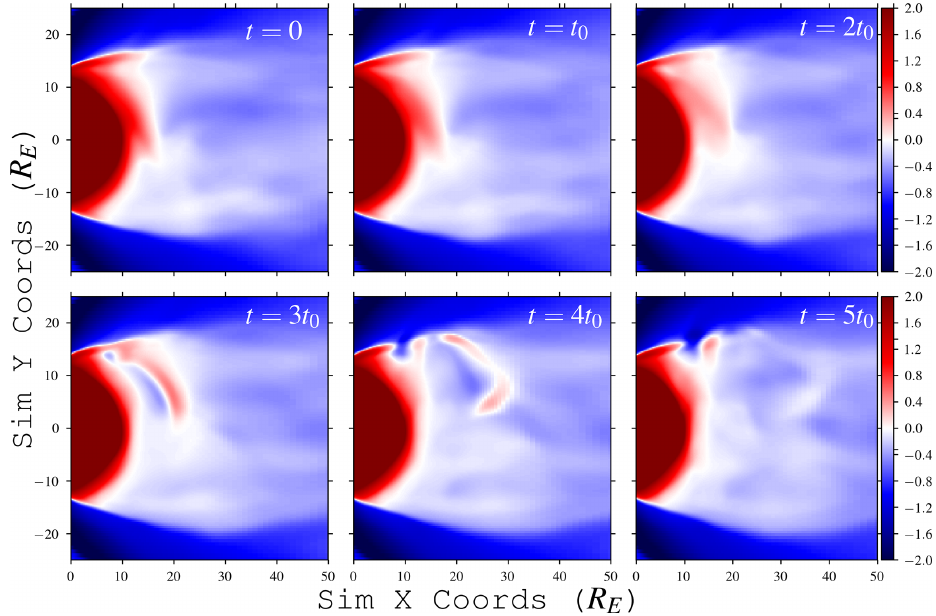
Figure 5. Formation and evolution of a global dipolarization over 5 t 0 ≈ 5 . 4min, as seen in the evolution of magnetotail normal magnetic field B z (red: out-of-page; blue: into page). Displayed times are relative to upper left image; t = 0 here corresponds to 6 t 0 after the start of